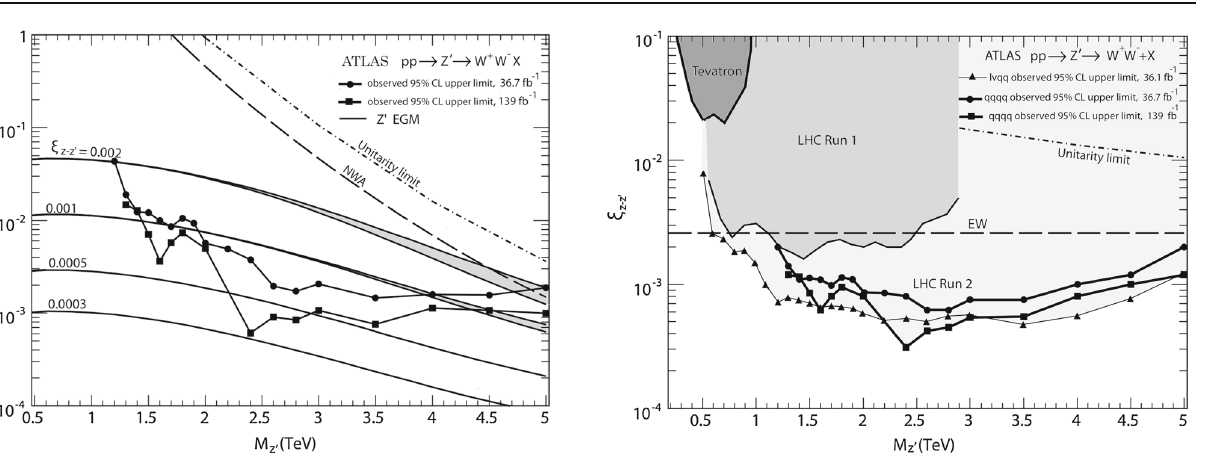
Fig. 5 Observed 95% CL upper limits on the production cross section times the branching fraction, σ 95% × BR ( Z (cid:2) → W + W − ) , as a func- tion of the Z (cid:2) mass, M Z (cid:2) , showing ATLAS data of the fully hadronic final states for 36 . 7 fb − 1 [36] and 139 fb − 1 [37]. Theoretical production cross sections σ( pp → Z (cid:2) + X ) × BR ( Z (cid:2) → W + W − ) for the EGM are calculated from PYTHIA with a K -factor used to correct for NNLO QCD effects, and given by solid curves, for mixing factors ξ Z − Z (cid:2) rang- ingfrom2 · 10 − 3 anddownto3 · 10 − 4 .Theshadedbandsaredefinedlike in Fig. 2. The area lying below the long-dashed curve labelled NWA corresponds to the region where the narrow-resonance assumption is satisfied. The lower boundary of the region excluded by the unitarity violation arguments is also indicated by the dot-dashed curve [39,49]